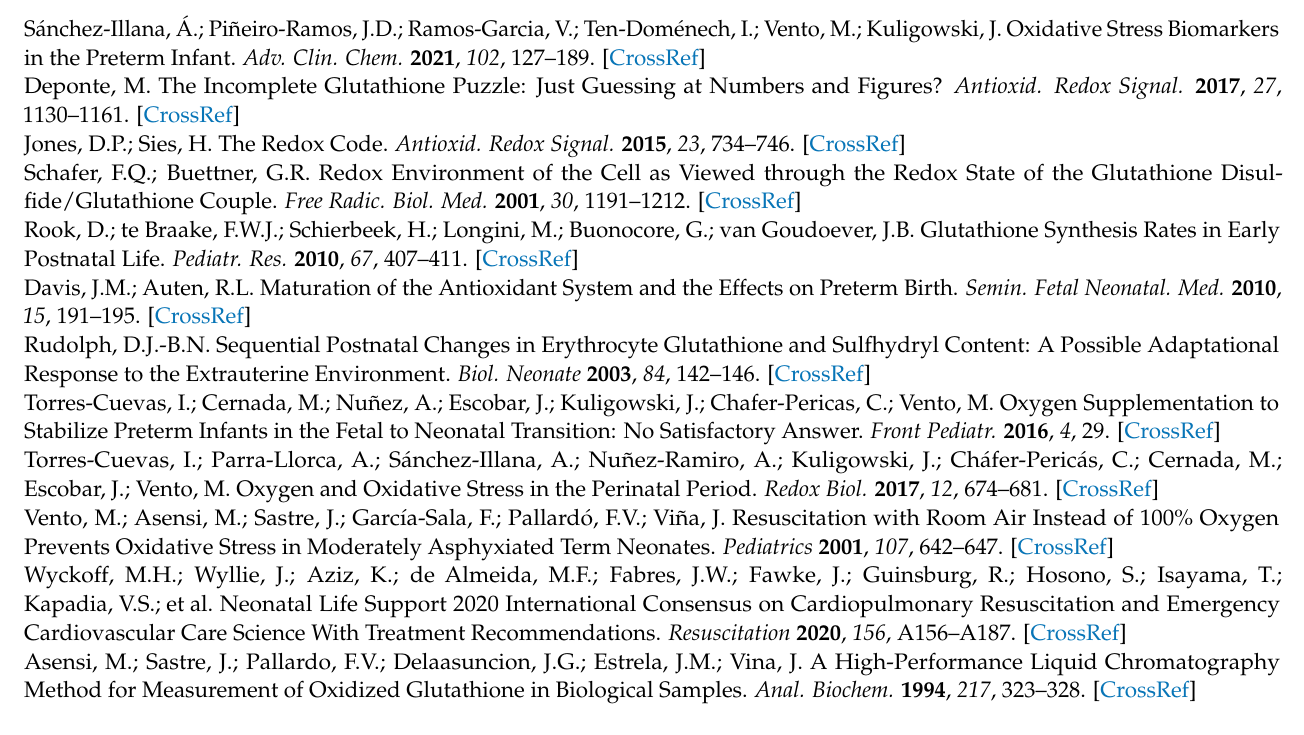
Figure S3: Bland–Altman plots with log-transformed data for the comparison between the DBS method and liquid blood method for GSH-NEM and GSSG; Figure S4: Linear fitting of the GSH-NEM concentration in cord blood with hematocrit (A); and GSH-NEM/GSSG with gestational age (B); and birth weight